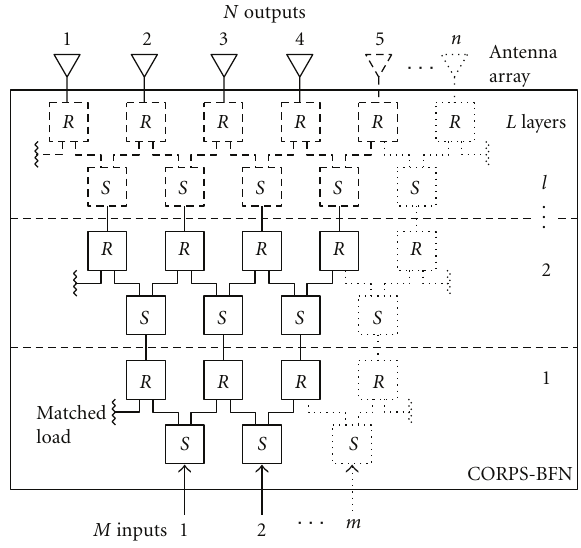
Figure 1: Schematic of CORPS beam-forming network with S and R nodes of M inputs, N outputs, and L